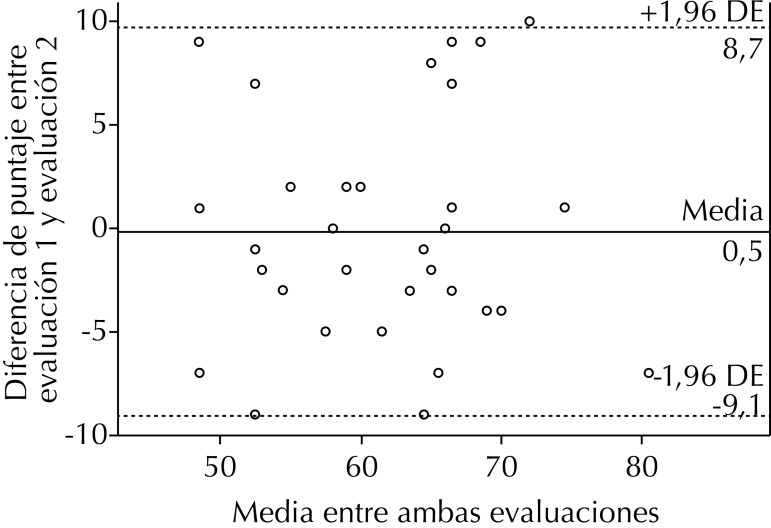
Bland-Altman Test re-test. Comparación de los puntajes TGMD-2-CH alcanzados por una muestra evaluada dos veces. Santiago de Chile, 2013. (N = 32)